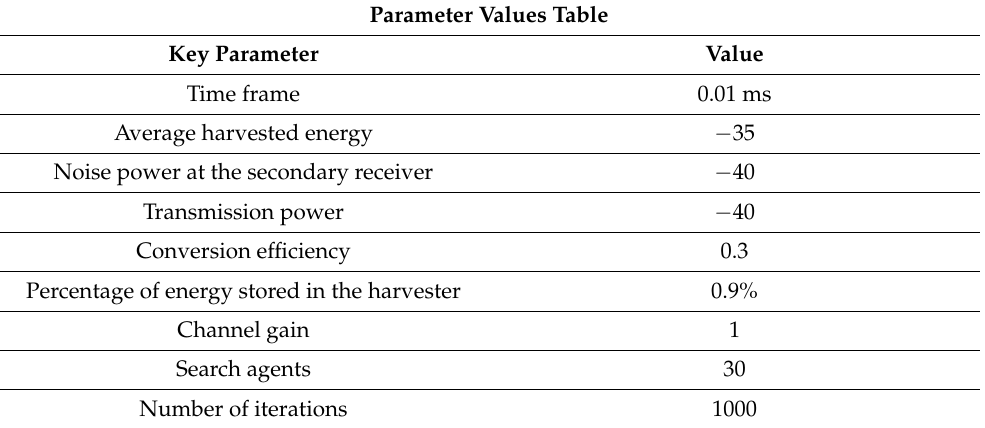
Table 2. System Parameters.